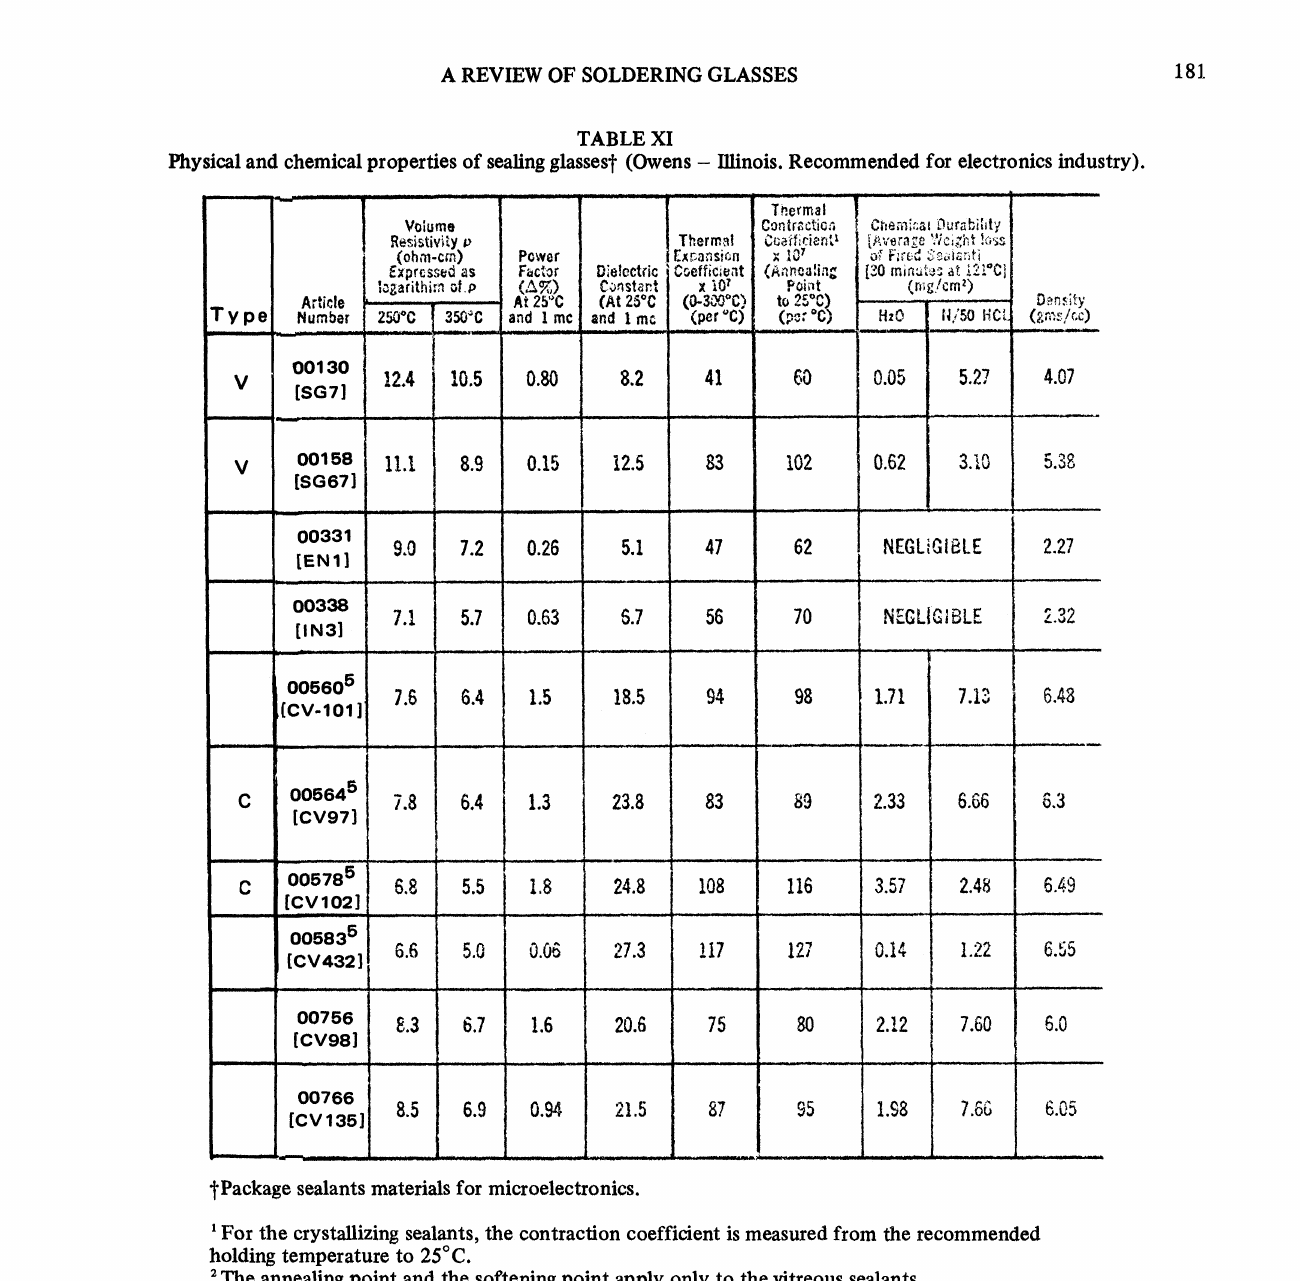
Physical and chemical properties of sealing glasses